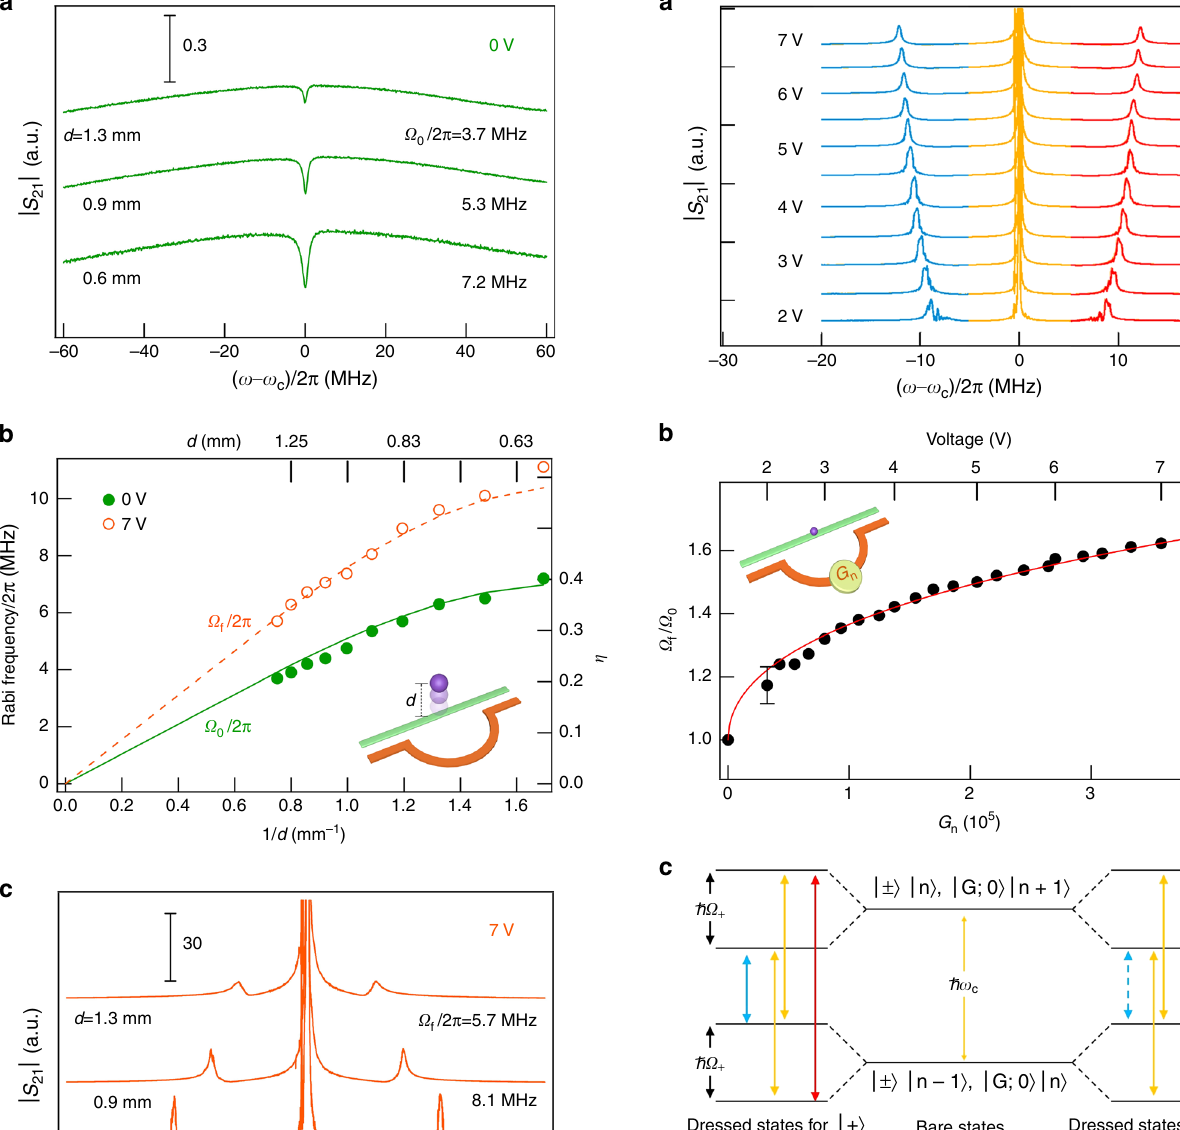
Dressed states for ⎮ + 〉 Dressed states for ⎮ – 〉 Bare Fig. 3 Voltage dependent Rabi frequency. a | S 21 | spectra measured at Δ = 0 and d = 0.58 mm ( Ω 0 /2 π = 7.5 MHz), for a series of V . b The measured (circles) and calculated (curve) ratio of Rabi frequencies Ω f / Ω 0 plotted as a function of V and G n . The error bar is the maximum uncertainty caused by the error when fi tting the Rabi frequency. c Schematic dressed states of both CMP modes. At Δ = 0, they produce the Mollow triplet with Ω + = Ω − . At Δ ≠ 0, they produce the magnon quintuplet with Ω þ ≠ Ω (cid:3) . The detuning between the bare states is not shown for